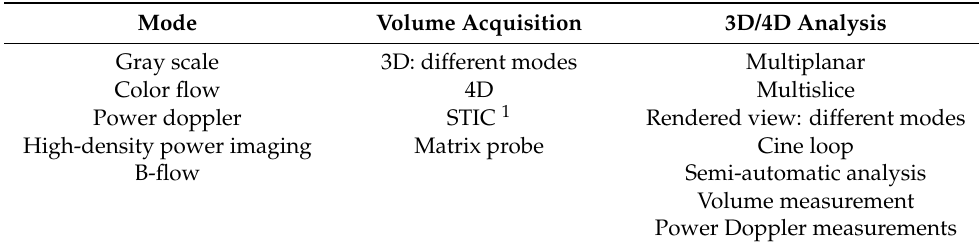
Table 1. Commonly used scanning mode, volume acquisition, and analysis for three-/four- dimensional (3D/4D) ultrasound